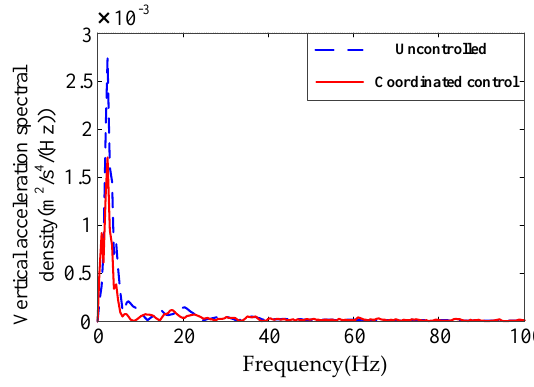
Figure 15. Vehicle driving path. Compared with the uncontrolled traditional air suspension, the spectral density of vertical